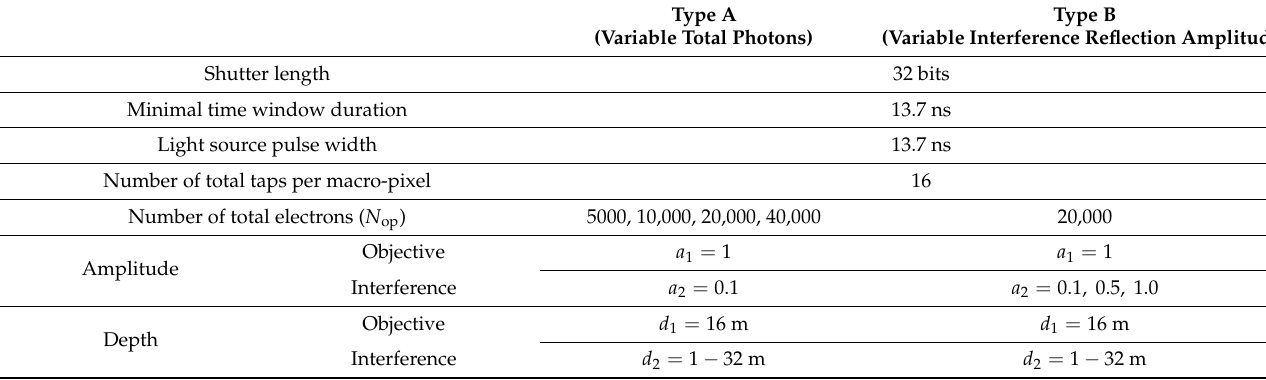
Table 3. Conditions of dual-path